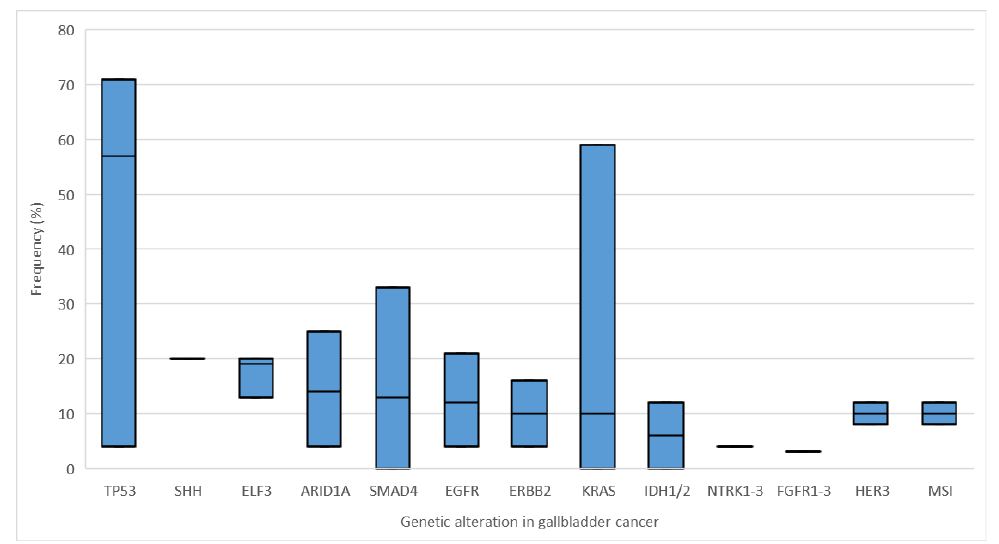
Figure 1. Common mutations in gallbladder cancer with average frequency and range (minimum and maximum) summarized from [20 – 24]. Average frequency (%) is displayed as a horizontal black line (average frequency without a range given is displayed as a black line only).